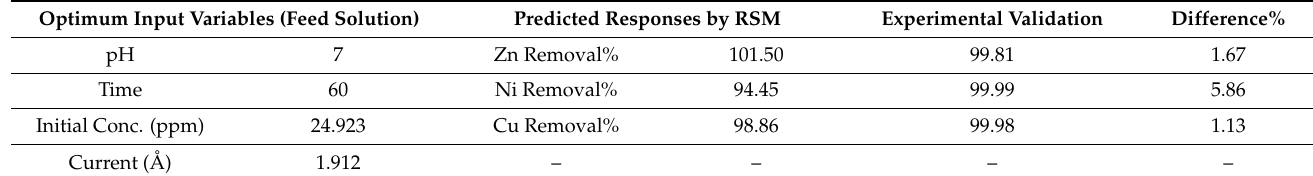
Table 7. EC Optimization of response through